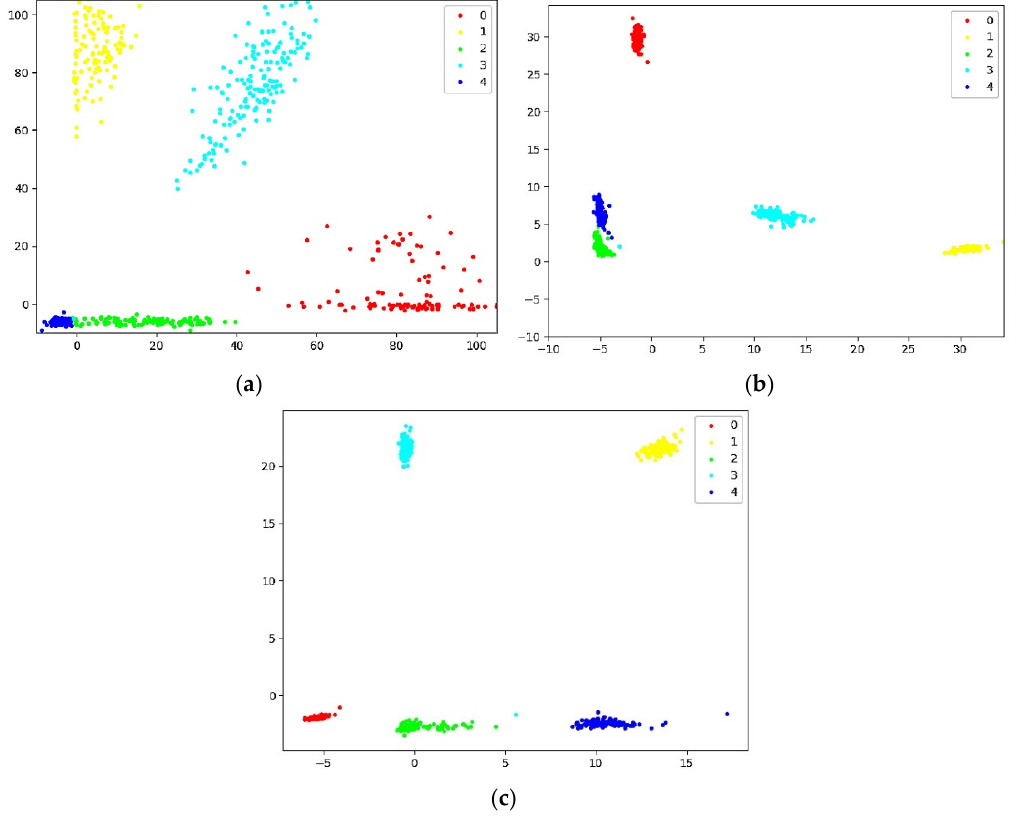
Figure 14. The output feature map of the network under different loss functions: ( a ) SoftMax loss; ( b ) center loss; ( c ) center distance loss. The points with different colors denote features from differ- ent classes.